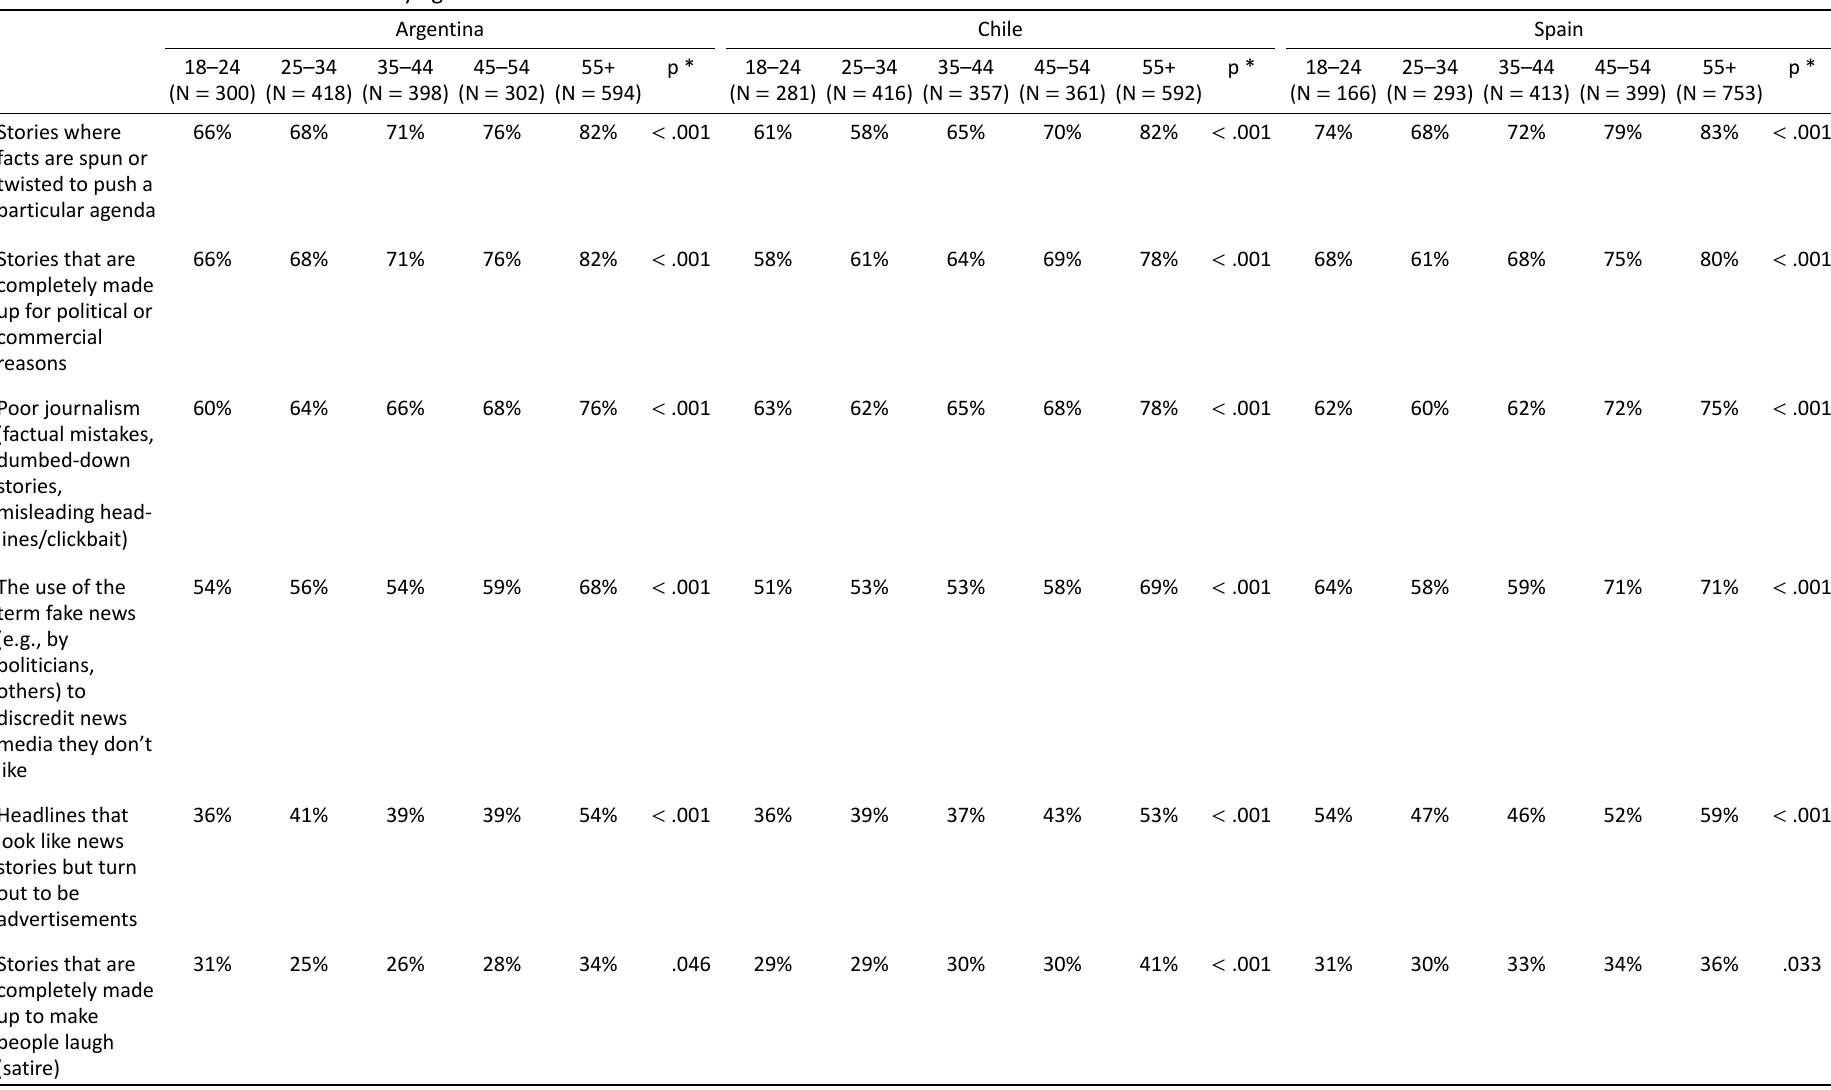
Table 3. Concern about disinformation by